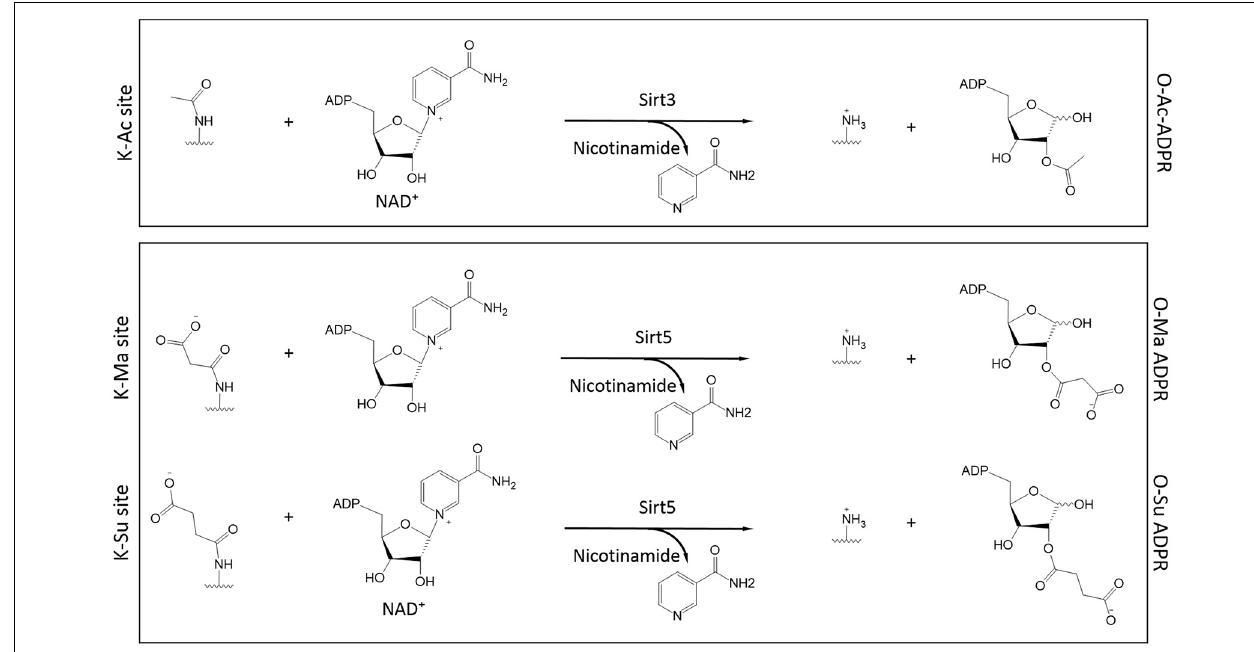
FIGURE 3 | Role of Sirt3 and Sirt5 in the catalysis of protein deacylation in the presence of NAD + . Sirt3 has specificity for acetylated lysines (K-Ac) whereas Sirt5 has broader specificity and it can accommodate malonylated and succinylated substrates (K-Ma and K-Su